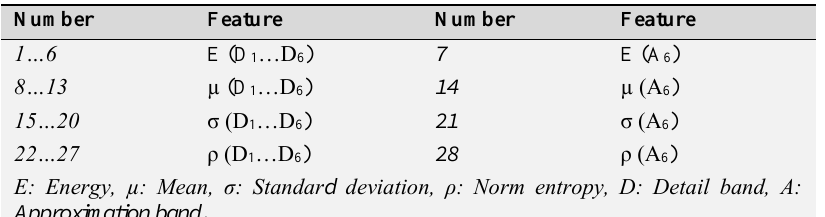
Table 2. Representation of the features.